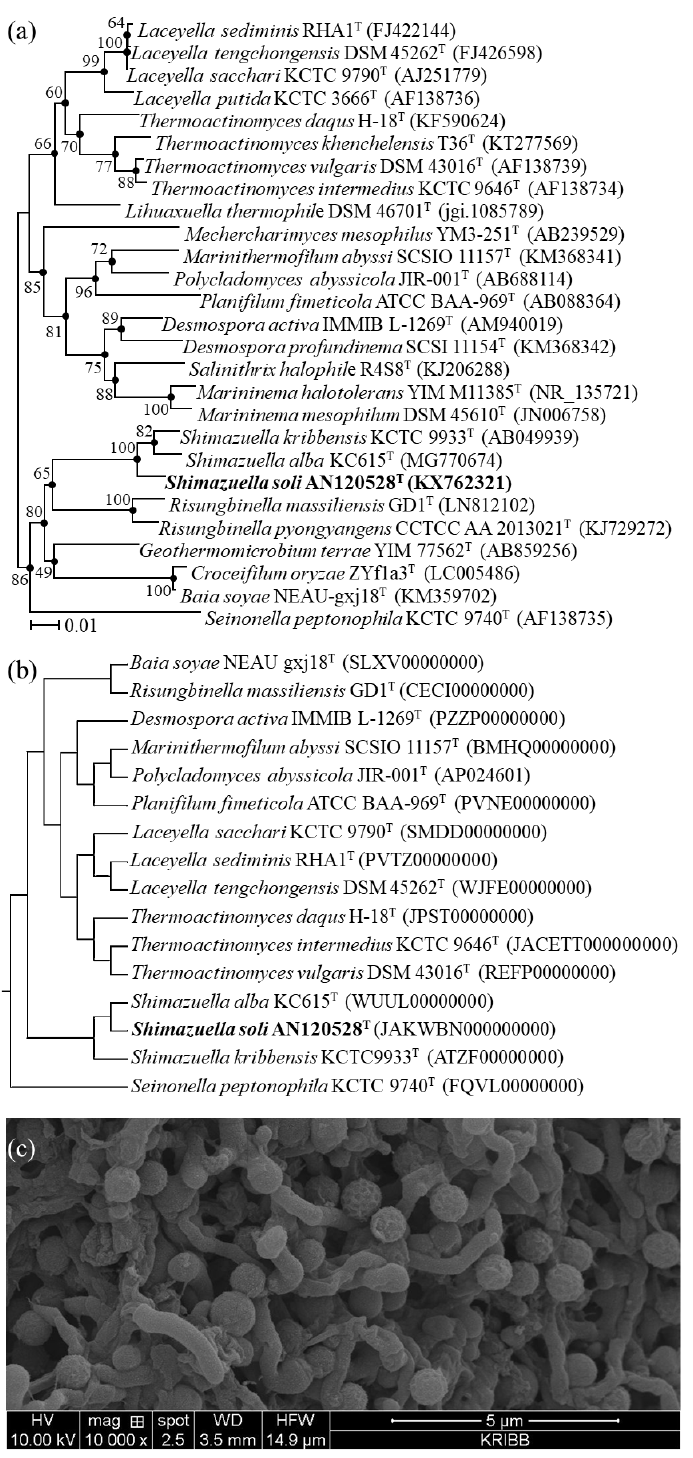
Figure 1. Phylogenetic tree, phylogenomic tree and SEM of the strain AN120528 T . ( a ) Neighbour- joining phylogenetic tree showing the relationships of the strain AN120528 T with S . alba KC615 T , S . KCTC 9933 T and other related species in the Thermoactinomycetaceae family. Bootstrap percentages (50%) based on 1000 re-samplings are given at the nodes. Dots indicate branches that were also recovered using the maximum-parsimony and maximum-likelihood algorithms. Bar, 0.01 substitutions per nucleotide position. ( b ) Phylogenomic tree of the genus Shimazuella and related genera. ( c ) SEM of the strain AN120528 T grown on an R2A agar plate for 5 days at 28 °C.